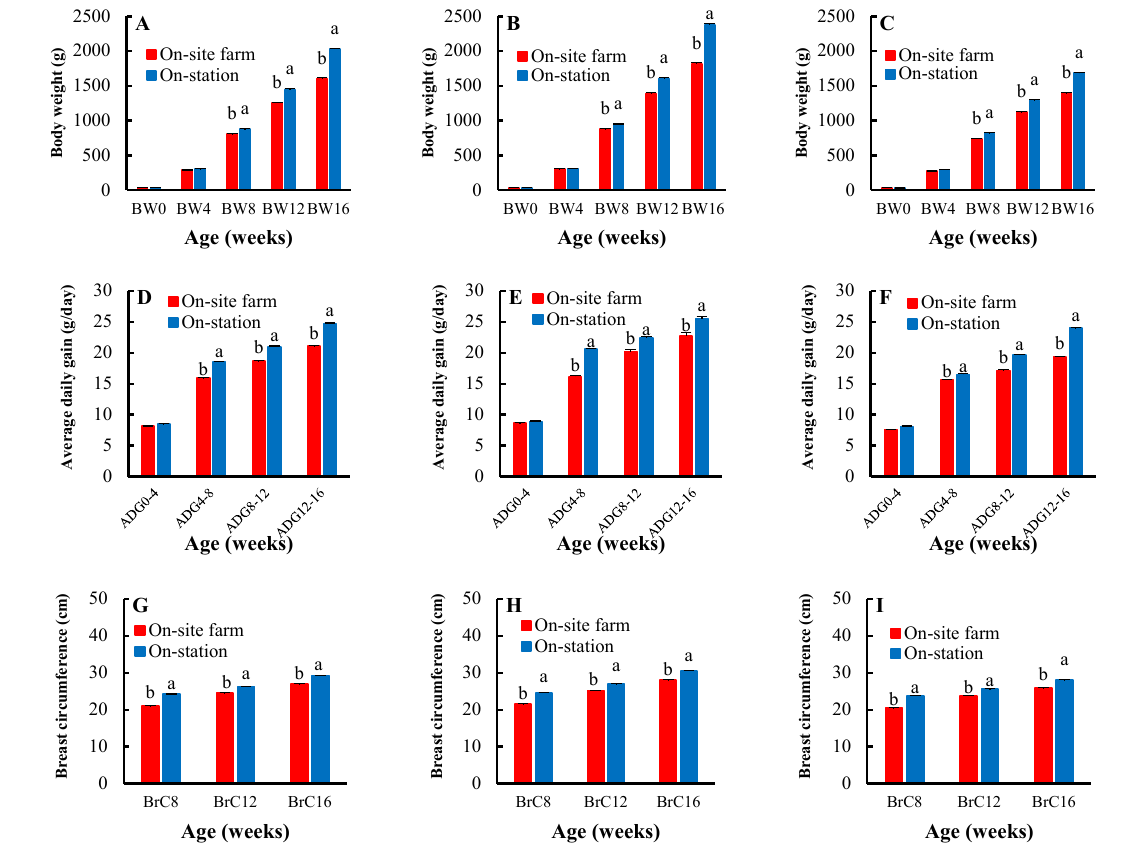
Figure 1. Least square means ± standard errors of the body weight of ( A ) mixed-sex chickens, ( B ) male chickens, and ( C ) female chickens at birth and 4, 8, 12, 16 weeks of age (BW0, BW4, BW8, BW12, BW16); average daily gain of ( D ) mixed ‐ sex chickens, ( E ) male chickens, and ( F ) female chickens from 0 – 4, 4 – 8, 8 – 12, and 12 – 16 weeks of age (ADG0 – 4, ADG4 – 8, ADG8 – 12, ADG12 – 16); breast cir ‐ cumference of ( G ) mixed ‐ sex chickens, ( H ) male chickens, and ( I ) female chickens at 8, 12 and 16 weeks of age (BrC8, BrC12, BrC16) between the on ‐ site farm (red bar) and on ‐ station (blue bar) ex ‐ periments using Thai native chickens (Pradu Hang dum). Means for the same trait with different letters (a, b) differ significantly ( p < 0.05). 3.2. Estimated Heritability Table 1 shows variance components and heritability of growth traits in term of body weight, average daily gain, and breast circumference at different ages in Thai native chicken raised on ‐ site farm and on ‐ station. The heritability estimates for body weight at all ages were moderate to high in the Thai native chickens raised on ‐ site farm and on ‐ station. The highest values were observed at birth, and the values decreased thereafter. In addition, the heritability estimates in Thai native chickens raised on ‐ station were slightly higher than those raised on ‐ site farm at all ages. The heritability estimates for the body weight of the Thai native chickens raised on ‐ site farm at birth and 4, 8, 12, and 16 weeks of age (BW0, BW4, BW8, BW12, and BW16) were 0.499, 0.464, 0.394, 0.236, and 0.244, re ‐ spectively, while the estimates for those raised on ‐ station were 0.499, 0.496, 0.413, 0.317, and 0.291, respectively. The heritability estimates of ADG in Thai native chickens raised on ‐ site farm and on ‐ station at all ages were moderate, and ranged from 0.274 to 0.283 and 0.298 to 0.313, respectively. The highest heritability estimates of ADG were found from 0 – 8 weeks of age (ADG4 – 8) in both the on ‐ site farm and on ‐ station chickens. The heritability estimates of breast circumference at BrC8, BrC12, and BrC16 were moderate in both on ‐ site farm and on ‐ station, with slightly higher on ‐ station values (0.296, 0.291, and 0.278, respectively) than on ‐ site farm values (0.268, 0.251, and 0.204, respectively). Table 1. Variance components and heritability (±standard error; SE) of growth traits between the on ‐ site farm and on ‐ station Thai native chickens (Pradu Hang dum). Research Sites